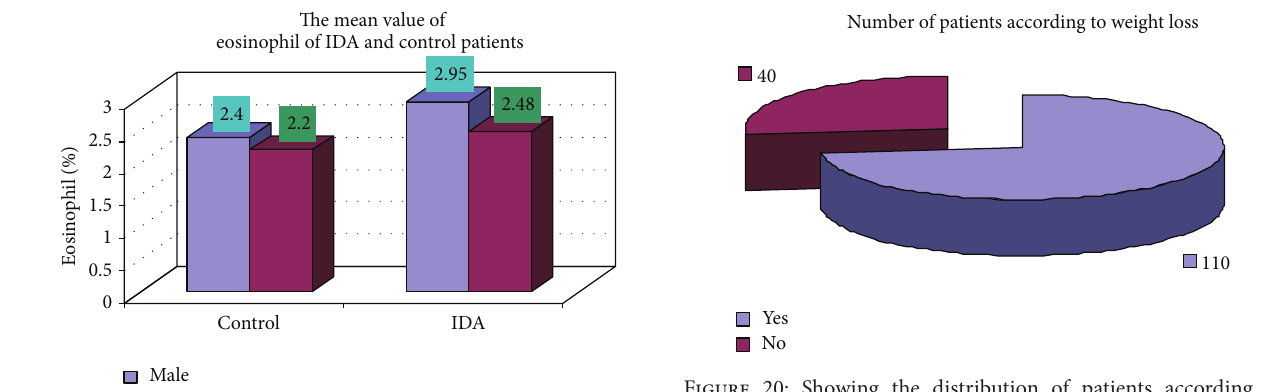
Figure 20: Showing the distribution of patients according to complaints of weight loss.